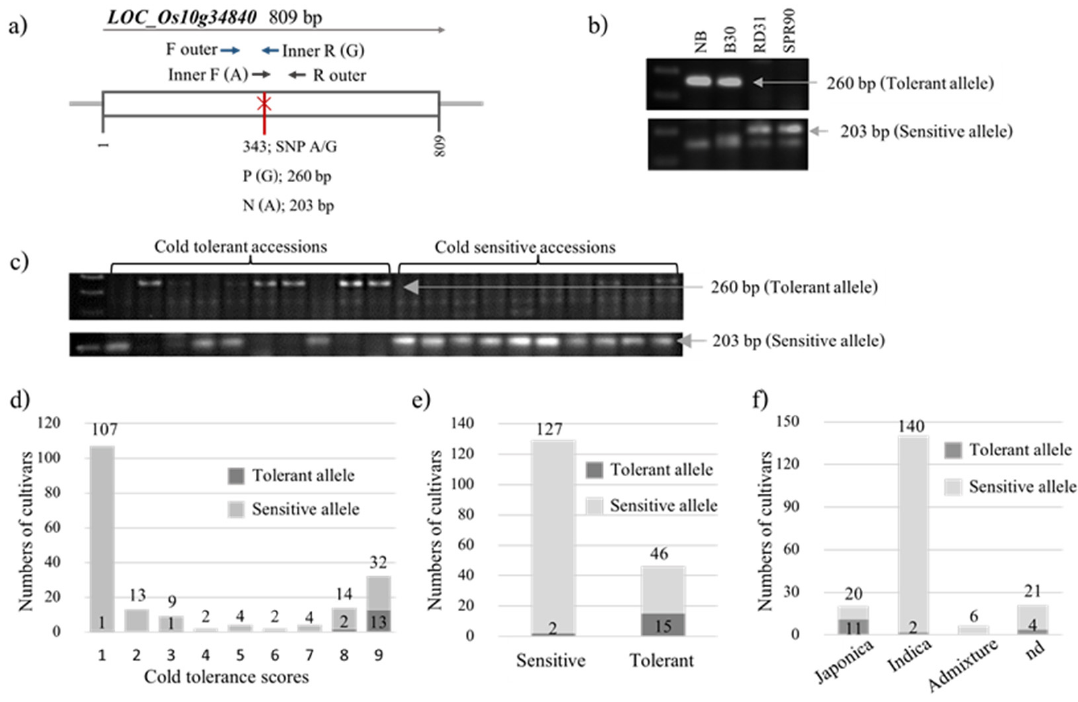
Figure 4. Mutation in LOC_Os10g34840 and its marker used for genotyping. ( a ) Structure of LOC_Os10g34840 showing polymorphic sequences between japonica (Nipponbare) and indica (9311). ( b ) Validation of the genotypic assay for two cold-tolerant (NB and B30) and two cold-sensitive (RD31 and SPR90) reference cultivars. ( c ) Representative examples of genotyping ten cultivars scored as cold-sensitive and ten cultivars scored as cold-tolerant among 187 accessions. ( d ) Allele frequency of LOC_Os10g34840 distributed in 1–9 cold tolerant scores of 187 rice accessions. ( e ) Allele frequency of LOC_Os10g34840 in extremely tolerant (score 8,9) and extremely sensitive (score 1–3) rice accessions. ( f ) The distribution of tolerant and sensitive alleles of LOC_Os10g34840 in each subspecies group among 187 accessions .